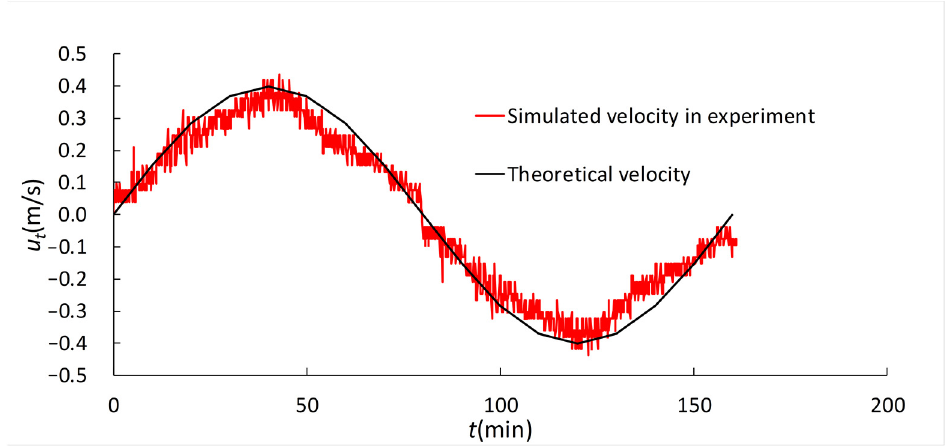
Figure 4. Time history of simulated bidirectional tidal current velocity. Table 1. Parameters of the experiments for unidirectional and bidirectional tidal currents.